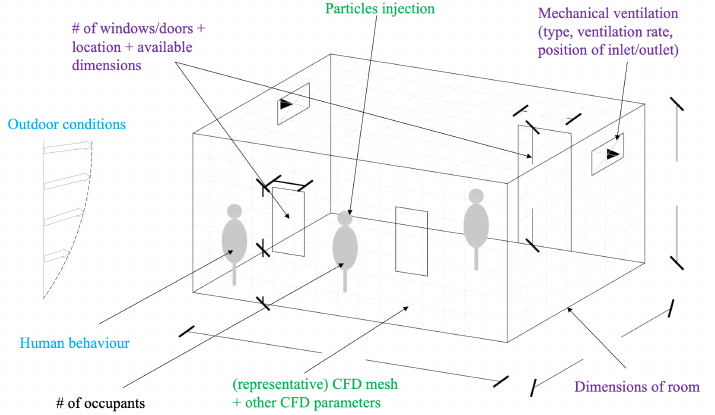
Figure 2. Input for CFD simulations. Green indicates the technical parameters; purple indicates the design parameters; blue indicates are stochastic input; black indicates additional information for specific